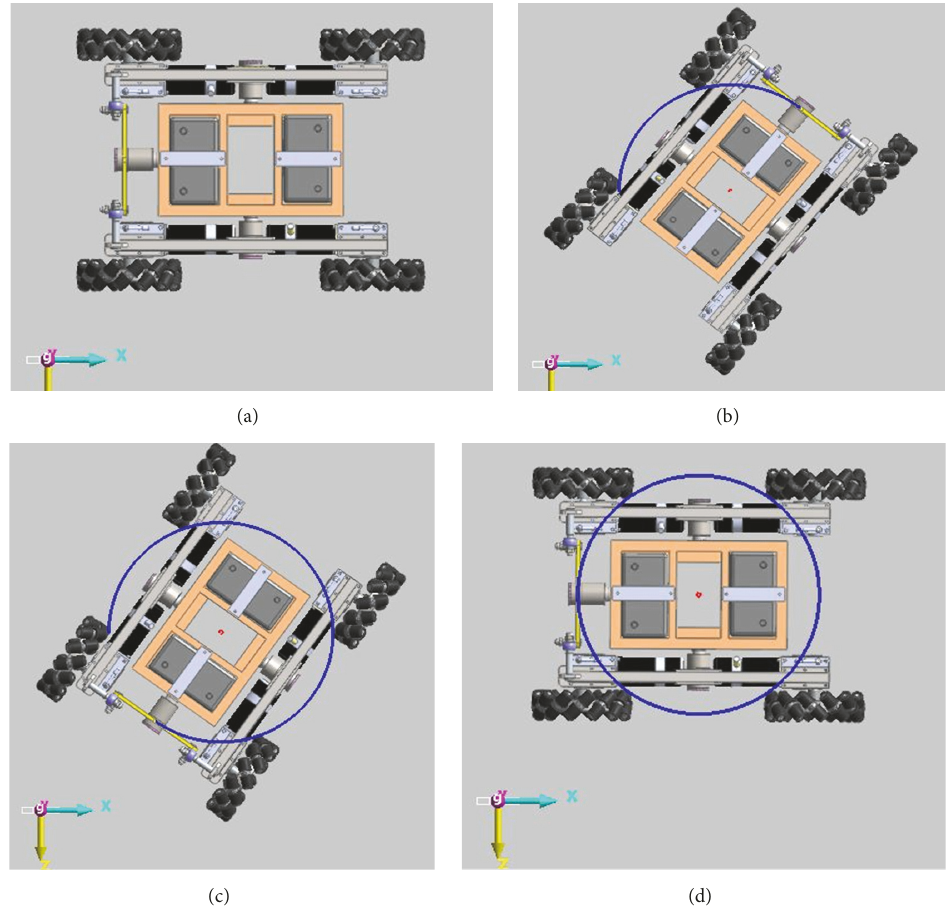
Figure 8: Trajectory of the MWP during the original-place rotation.